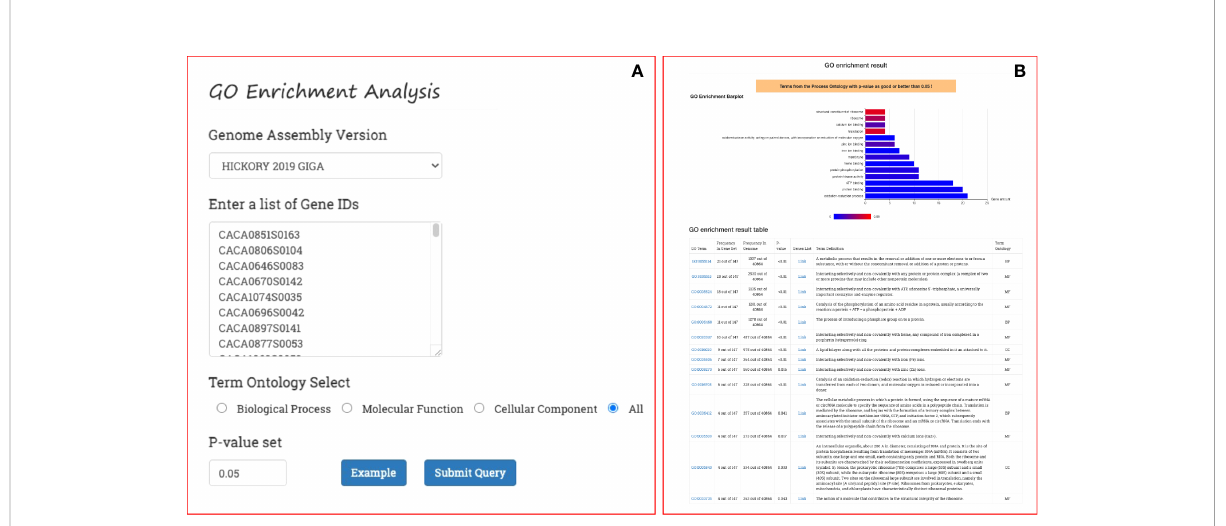
FIGURE 5 GO and KEGG enrichment analysis process in GROP. (A) Submission form for genome version, gene set, ontology term, and p-value. (B) Returned enrichment result, including a histogram and a summary